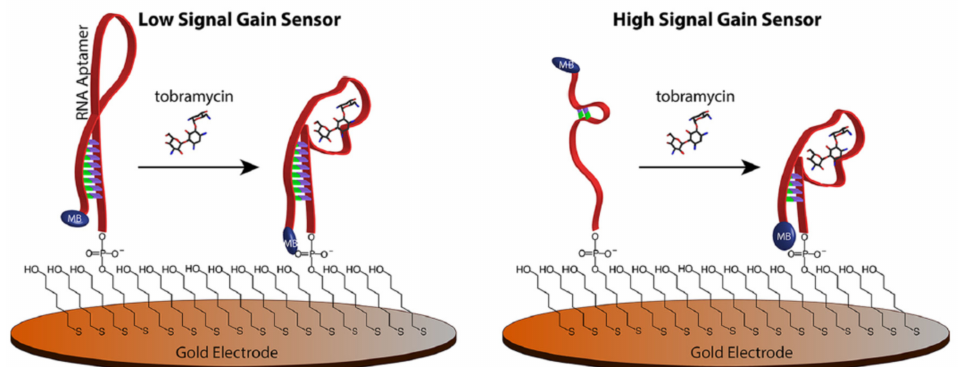
Figure 4. Schematic illustration of two electrochemical aptasensor architectures: a low signal gain sensor and a high signal gain sensor. The latter illustration shows a larger change in conformation upon target binding thus leading to a high signal change. Reprinted with permission from Schoukroun-Barnes LR, Wagan S, White RJ. 2014. Enhancing the Analytical Performance of Electrochemical RNA Aptamer-Based Sensors for Sensitive Detection of Aminoglycoside Antibiotics. Anal. Chem. 86:1131–1137. Copyright (2013) American Chemical Society.